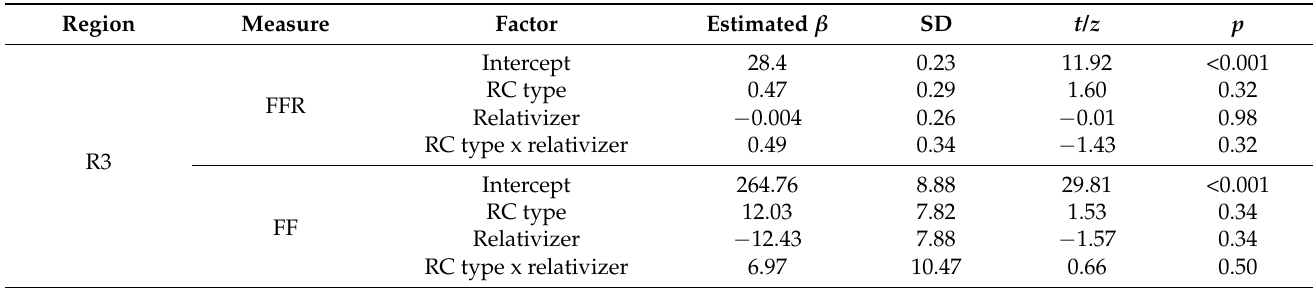
Table 7. Estimated values from the linear mixed-effect models and mixed-effect logistic regression for the contrast que versus quien at R3, R4, and R5. Eye movement measures are first-fixation rate (FFR), first fixation (FF), first-pass duration (FPD), first-pass regression (FPR), quasi-first-pass reading time (QFP), and second-pass duration (SPD). t -values refer to reading time measures, and z -values refer to probability